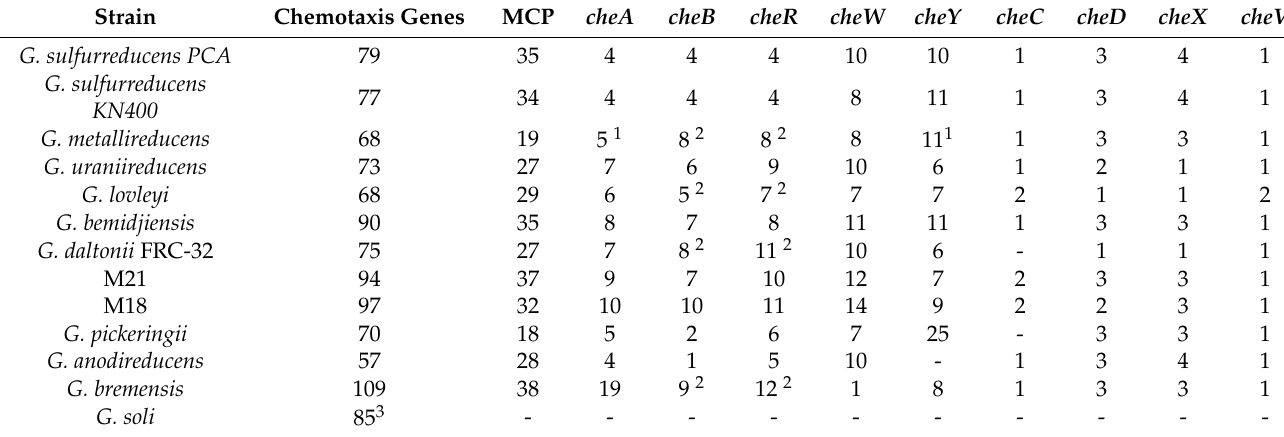
Table 2. Number of chemotaxis and che genes obtained from the analysis of Geobacter available genomes. Strain Chemotaxis Genes MCP cheA